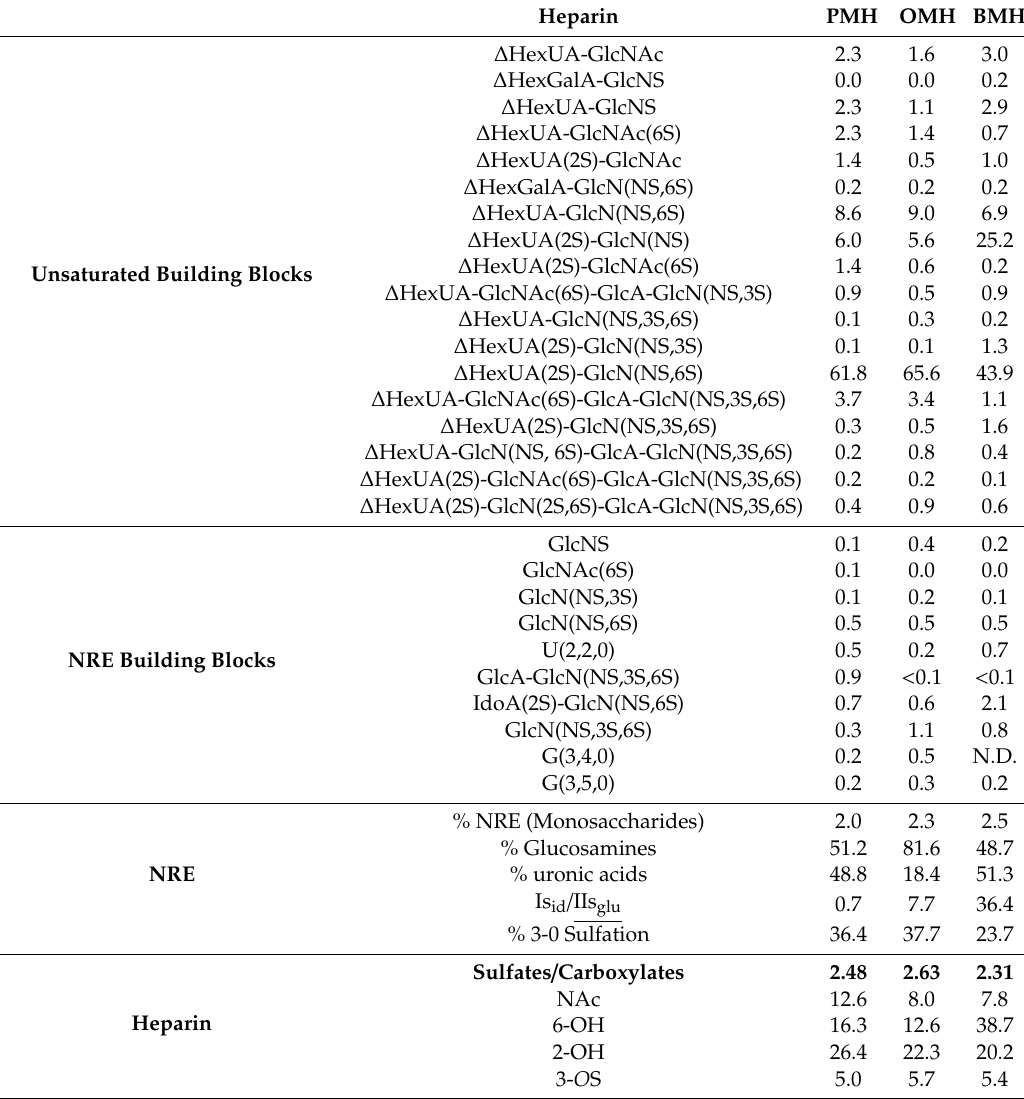
Table 2. Quantification of building blocks (% w / w ) for PMH, OMH, and BMH (NAc: % N -acetylated glucosamines; 6-OH: % 6-OH glucosamines; 2-OH: % 2-OH uronic acids; 3- O S: % 3- O sulfated glucosamines). Heparin PMH OMH BMH